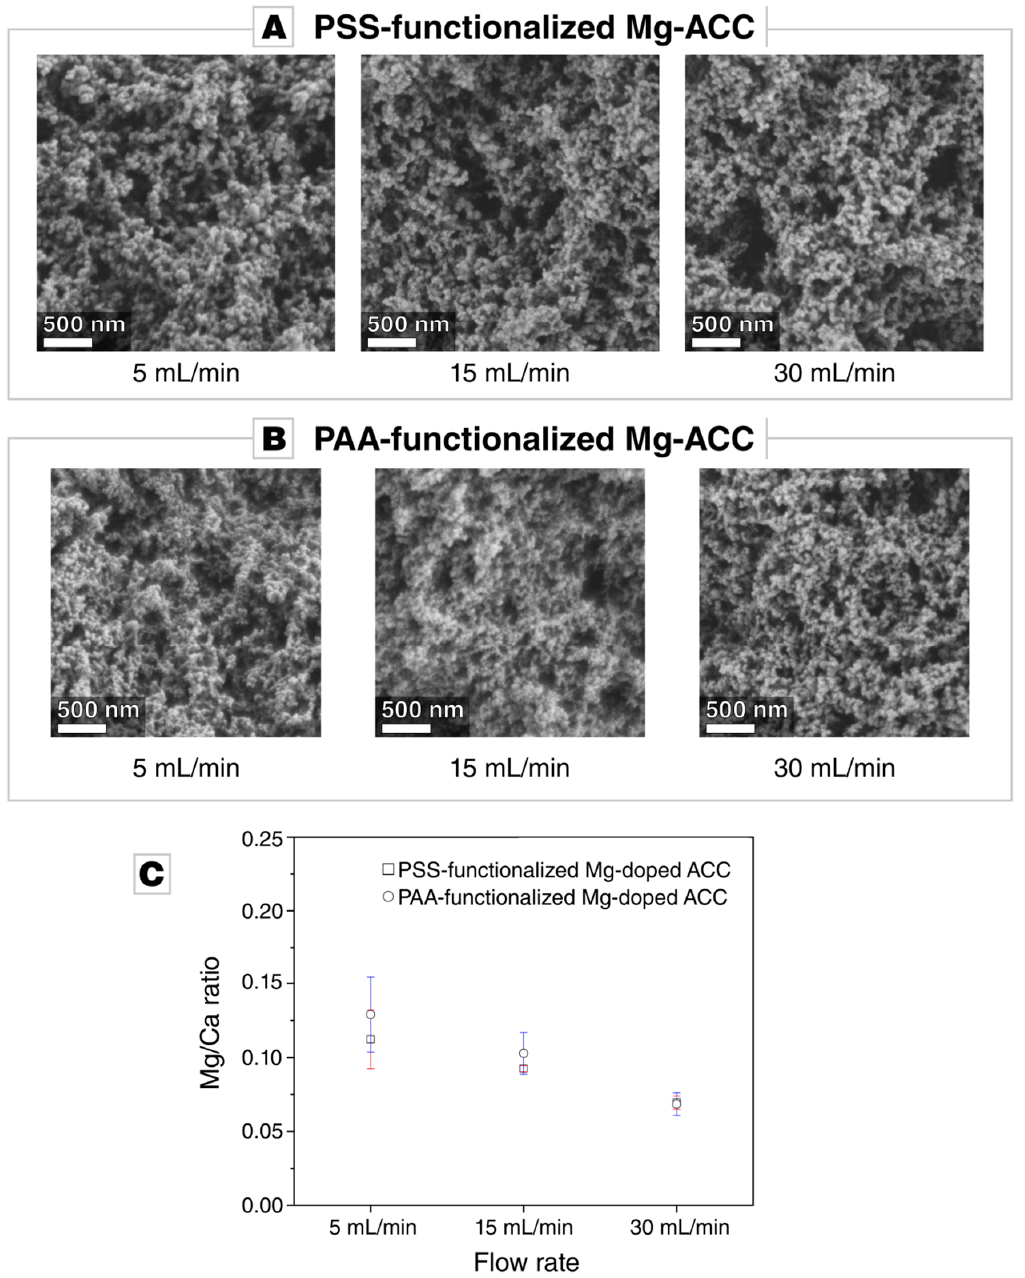
Figure 2. ( A , B ) Micrographs acquired by scanning electron microscopy of Mg-doped amorphous Figure 2. (A,B) Micrographs acquired by scanning electron microscopy of Mg-doped amorphous calium carbonate (ACC) functionalized by di ff erent polymers, i.e., sodium poly(4-styrenesulfonate) calium carbonate (ACC) functionalized by different polymers, i.e., sodium poly(4-styrenesulfonate) (PSS) or sodium polyacrylate (PAA), synthesized at di ff erent flow rates: 5 mL / min, 15 mL /